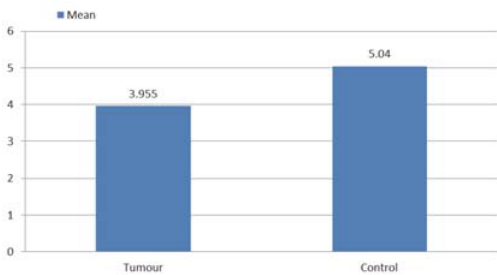
FIGURE 2. Decrease of intra and peritumoral LVD in inva- sive breast carcinoma compared to fi brocystic breast disease (p=0.002).